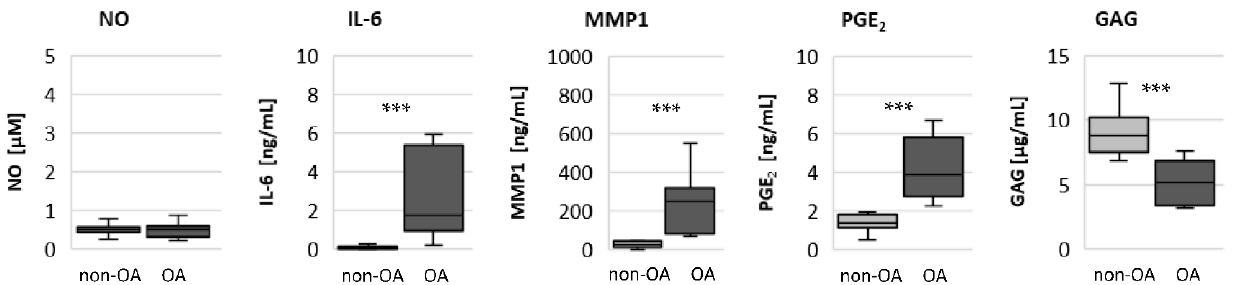
Figure 1. Basal release of NO, IL-6, MMP1, PGE 2 and GAG from non-OA (number of patients (N) = 8) and OA (N = 10) human hip chondrocytes. Statistics: non-OA vs. OA chondrocytes, Mann–Whitney U Test. *** p < 0.005.